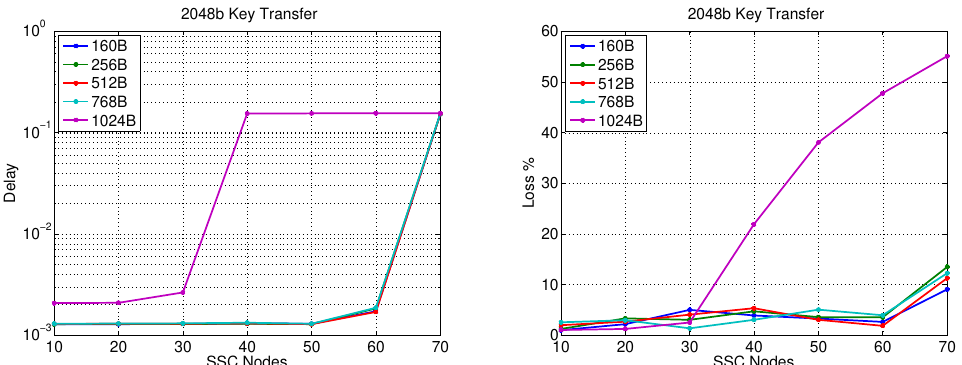
Figure 10. Gateway-PS communication performance for one SSC with different number of SSs (2048-bit key